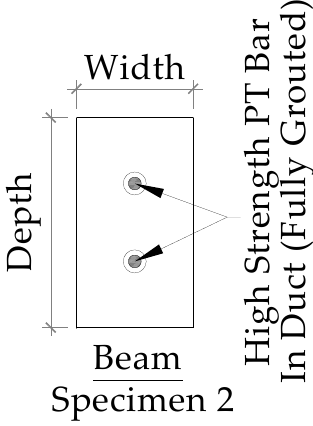
Figure 12. PT bar placed closer to the center and fully grouted. In Phase III, Priestley and Tao (1993) [32] performed a numerical analysis of a column and beam assembly with partially unbonded post-tensioned tendons (Figure 13). Tendons were unbonded along the column length and extended 48 in (1.22 m) into the beam. The tendons were placed closer to the beam centroid, as shown in Figure 13. Priestley and Tao [32] performed a dynamic nonlinear analysis to study the concept of partially unbonded frames. They predicted that the debonded system would result in the maintenance of pre- stress compression after seismic displacement. Residual displacement would be negligi- ble. They suggested special spiral reinforcement at the beam ends to ensure satisfactory performance in the plastic hinge regions. Ductility demands of partially debonded and fully bonded tendons would be the same; however, for short period structures high dis- placement ductility demands can be expected. They suggested experimental research to confirm the numerical results.